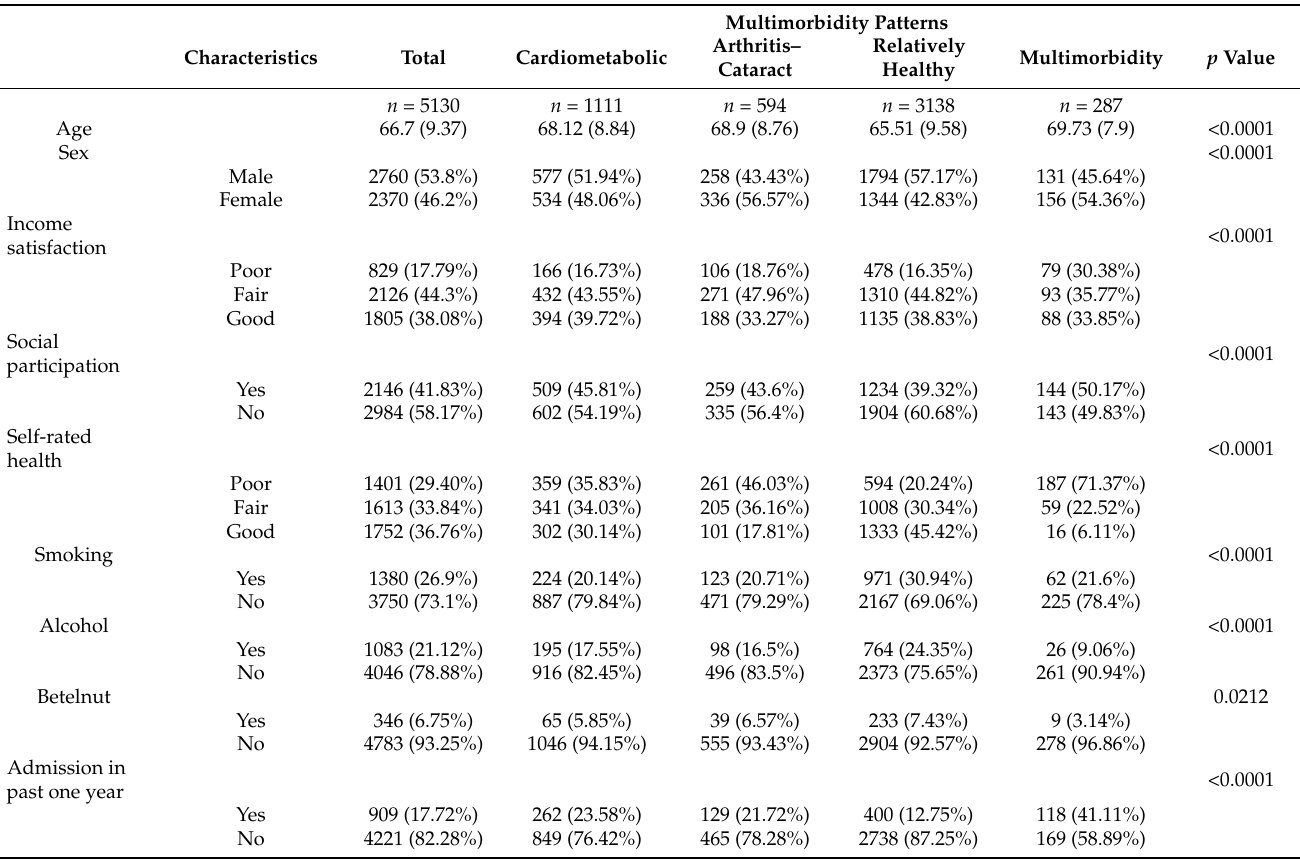
Figure 5. Multimorbidity patterns in 2011. The baseline demographic characteristics showed higher rates of poor income satis- faction, self-rated health, admission experience, disability, and depression in the multi- morbidity group than in the other groups (Table 1). Table 1. Demographic and clinical characteristics of the participants in 1996.